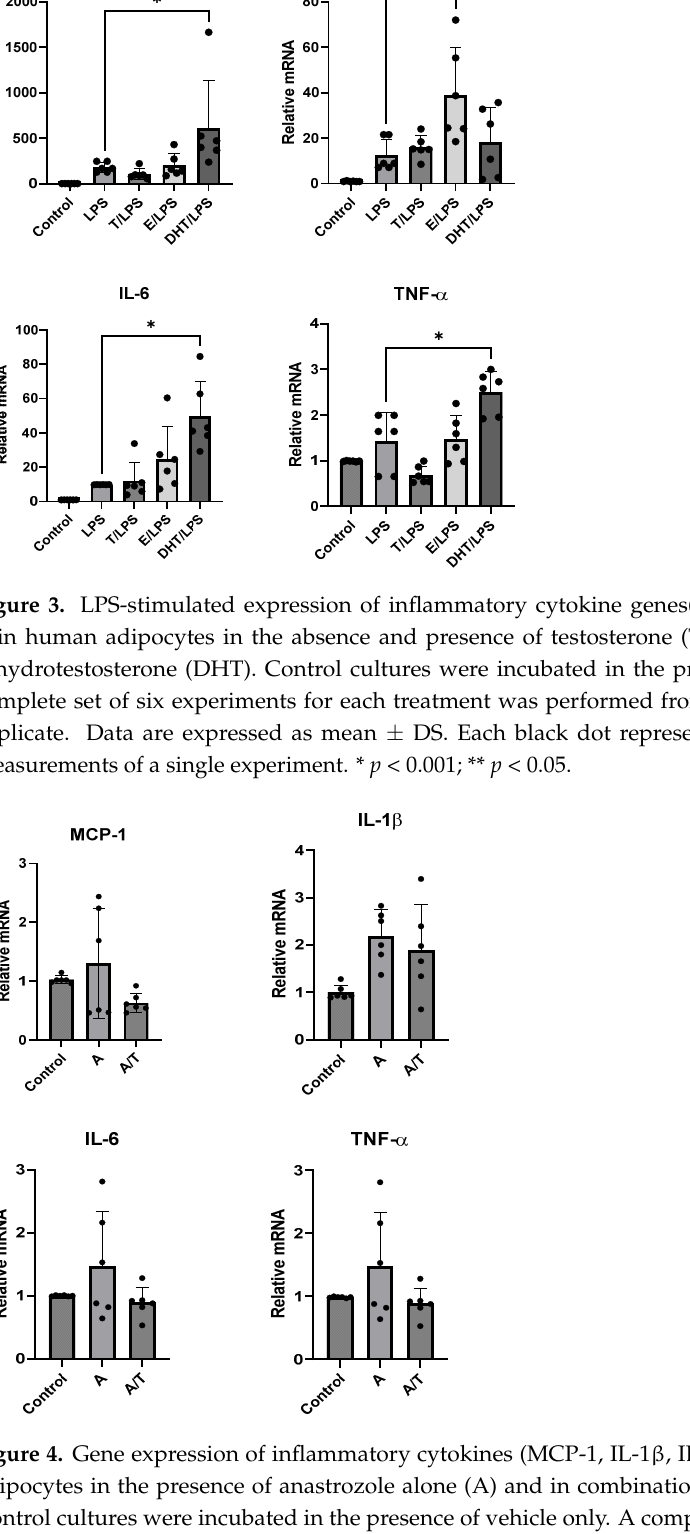
Figure 4. Gene expression of inflammatory cytokines (MCP-1, IL-1 β , IL-6, and TNF- α ) in human adipocytes in the presence of anastrozole alone (A) and in combination with testosterone (A/T). Control cultures were incubated in the presence of vehicle only. A complete set of six experiments for each treatment was performed from each subject and run in triplicate. Data are expressed as mean ± DS. Each black dot represents the mean of triplicate measurements of a single experiment.